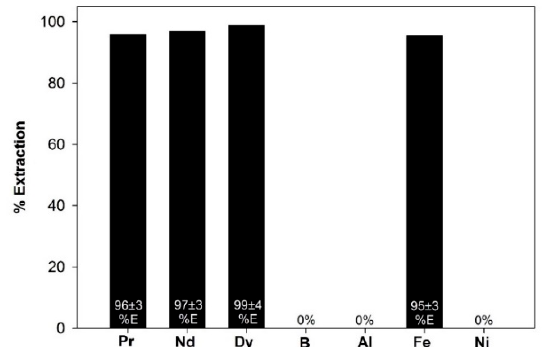
Figure 13. Extraction from neodymium iron boron magnet materials with 0.5 mol% 1 ‐ octanol in CO2 (l) , 0.072 M TBDGA in 1 ‐ octanol TBDGA:M by mole, 23 °C, 24.1 MPa, and a flow rate of 5.0 ± 0.5 mL/min.